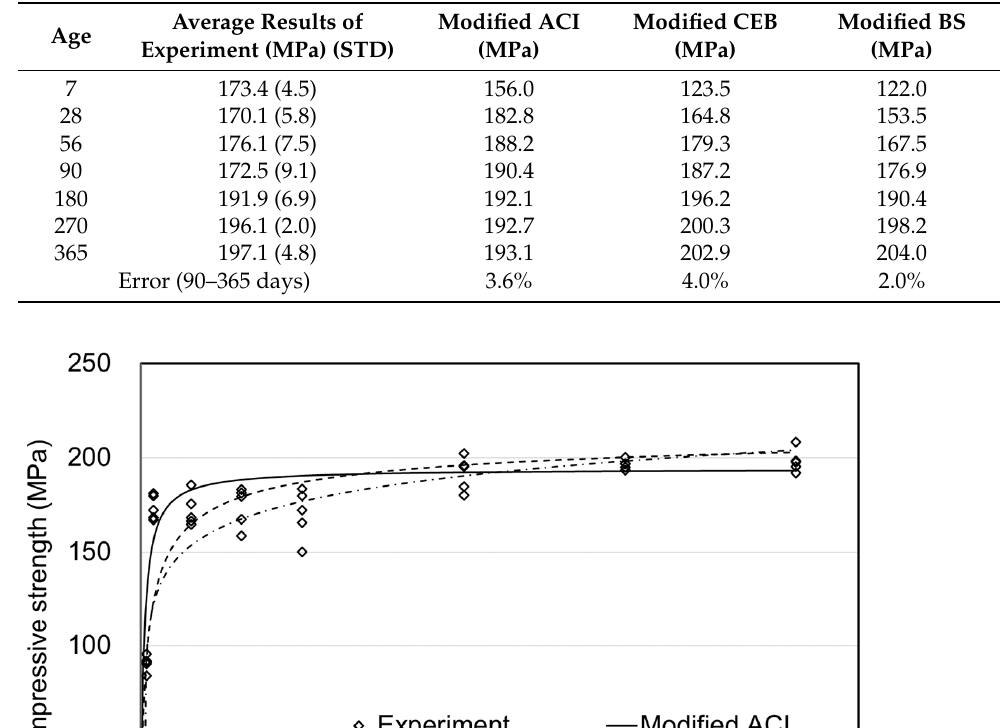
Table 5. Experiment results in steam curing compared with modified prediction models.